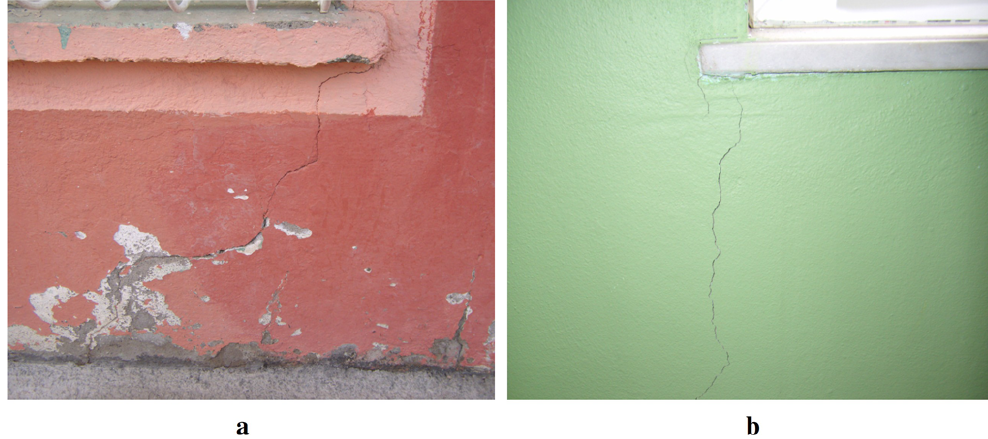
Fig. 27. Slight cracks at sill parts of window openings.